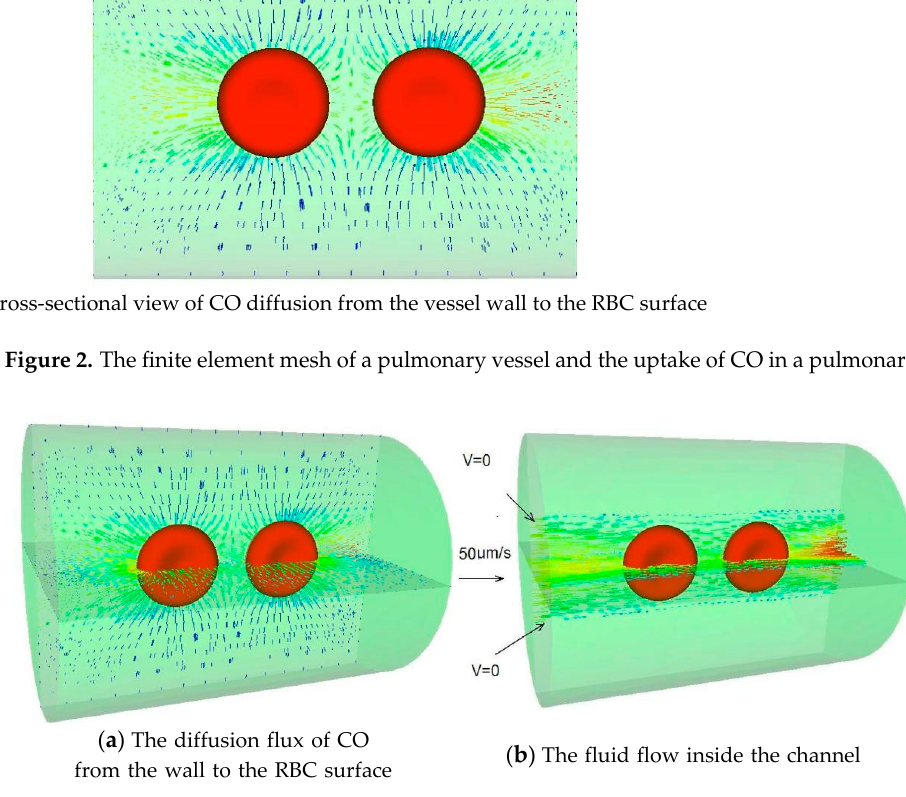
Figure 3. The uptake of CO in a cylindrical pulmonary vessel.